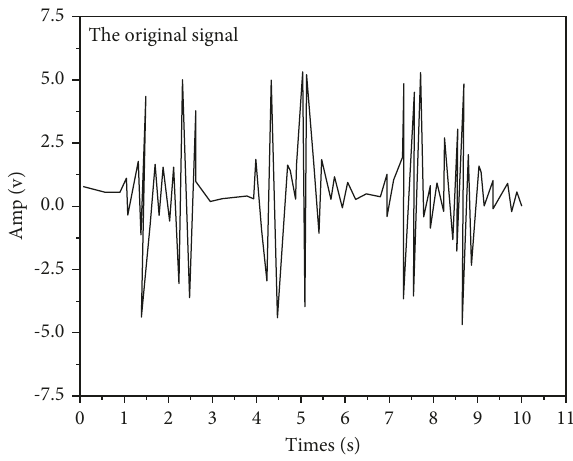
Figure 5: Part of the muscle acoustic